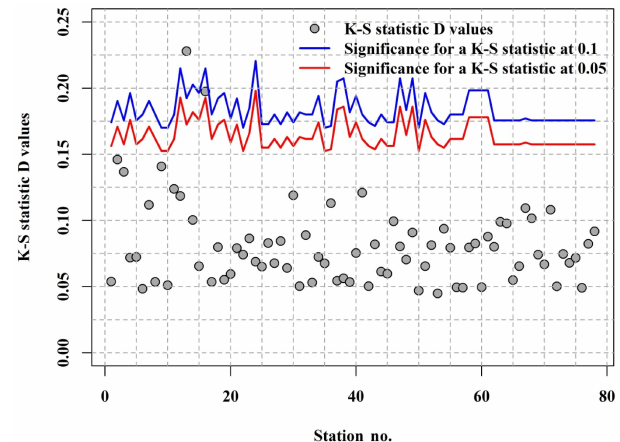
Figure 6. K–S test results of performance of GEV fitting of peak flood flow of the Pearl River